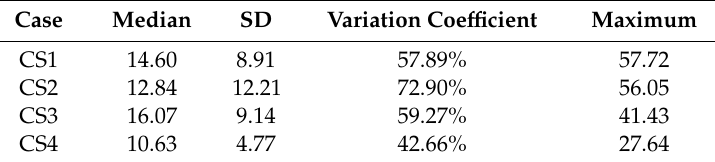
Table 9. The daily PM 2.5 means ( µ g / m 3 ) before lockdown.